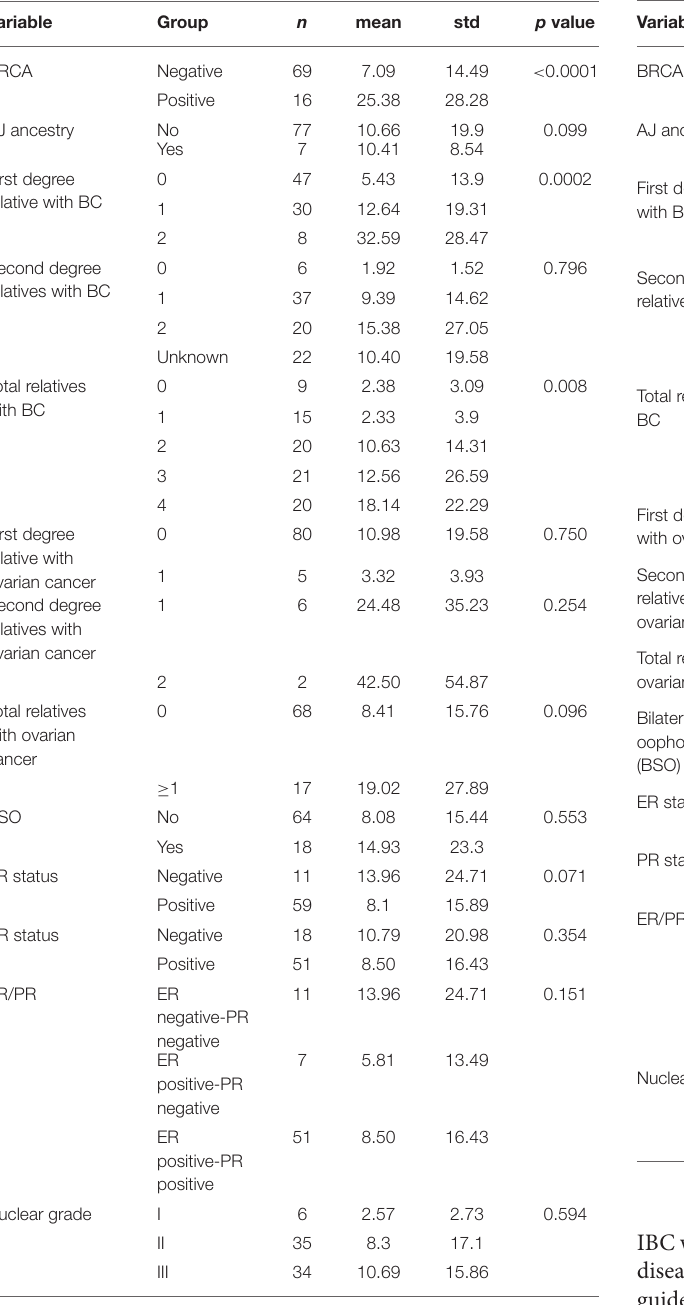
TABLE 4 | Comparisons of BRCAPRO with DCIS entered as no cancer by patient’s characteristics. Variable